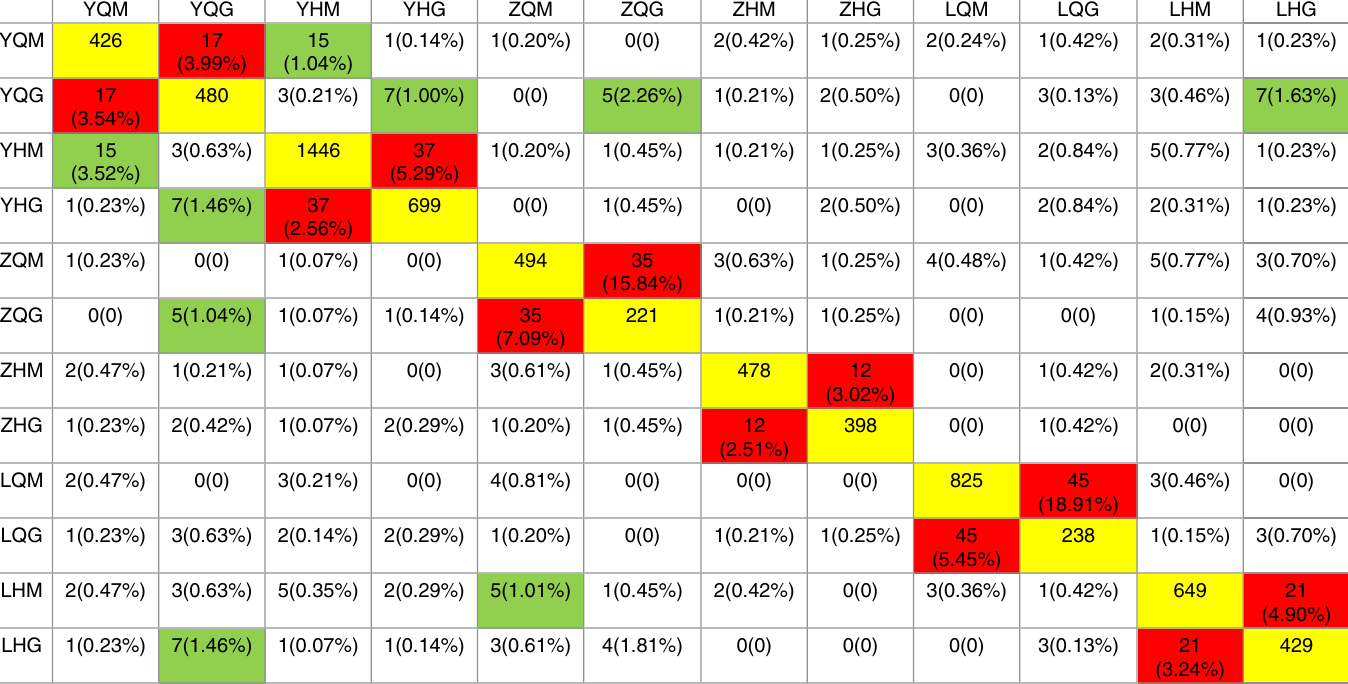
Table 4. The amount and frequency of sequences that overlap in the repertoires of IgM and IgG before and after immunization with HBV vaccines in 3